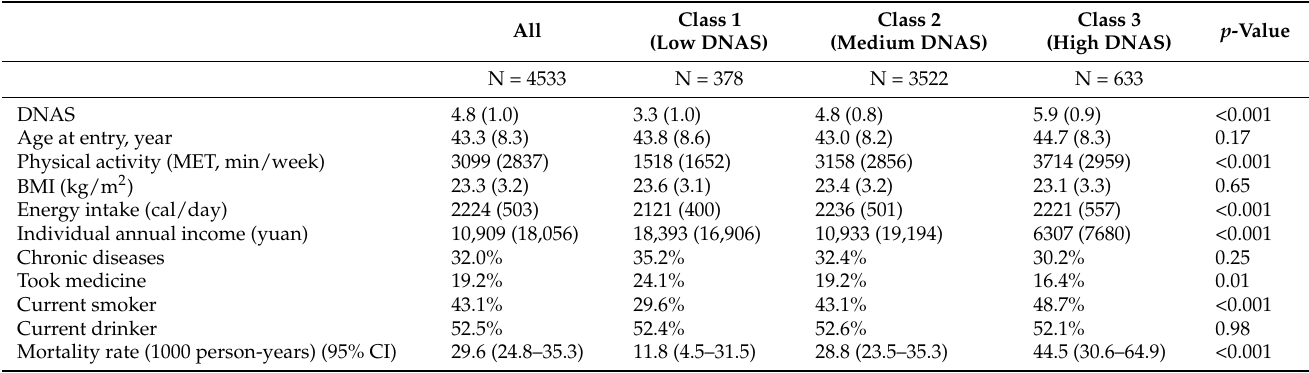
Table 1. Characteristics of participants across classes identified by latent class trajectory modeling (N = 4533). Class 1 Class 2 All (Low DNAS) (Medium DNAS)